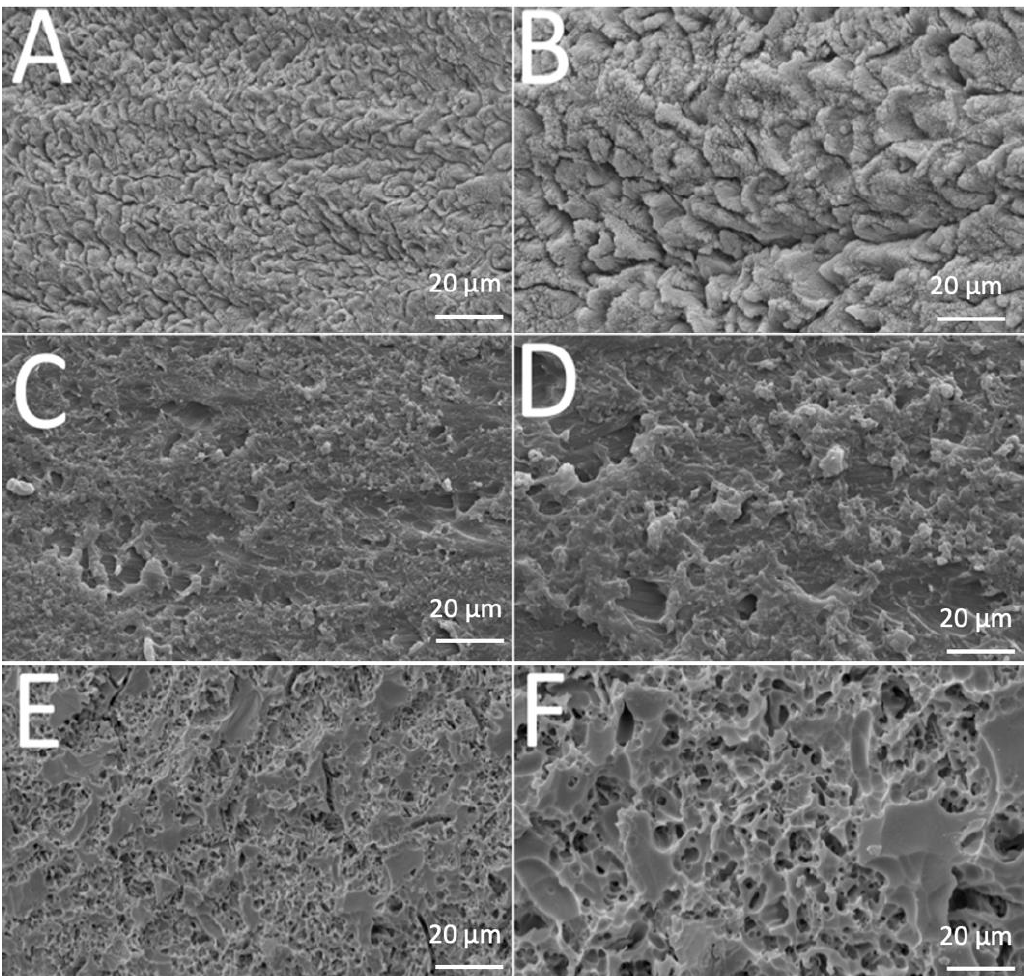
Figure 1. SEM images of ( A , B ) enamel, ( C , D ) acrylic or ( E , F ) leucite-based glass – ceramic after etching procedure.